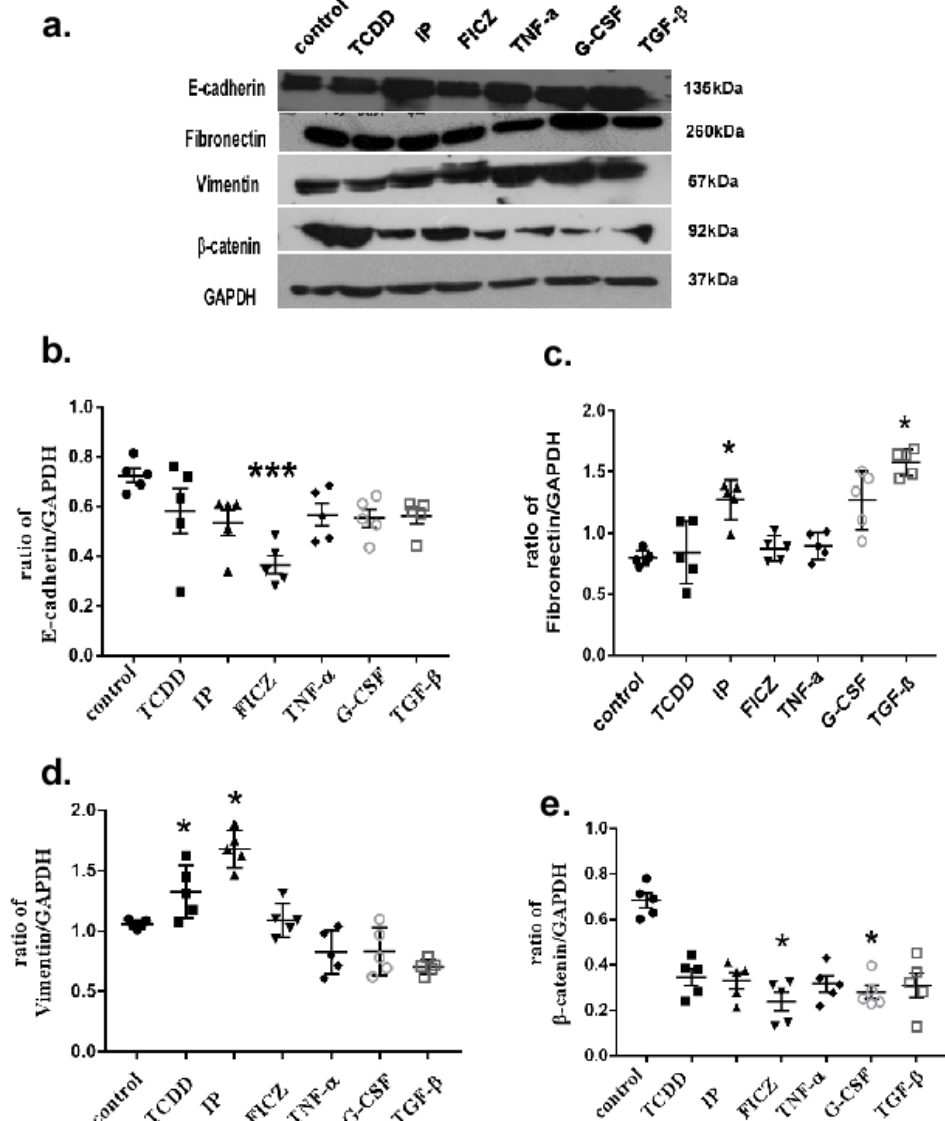
Figure 7. Activation of AhR induced epithelial EMT marker expression in MLE-12 cells. MLE-12 cells were exposed for another 24 h in serum-free DMEM/F12 media with TCDD (10 − 8 M), IP (10 − 7 M), FICZ (10 − 7 M), TNF- α (10 ng/mL), TGF- β (10 − 5 M) and G-CSF (10 ng/mL). ( a ) Representative image of western blot. ( b ) e-cadherin expression, ( c ) fibronectin expression, ( d ) vimentin expression, ( e ) β -catenin expression. Five independent experimental means ± SEM are represented in the graph. Unstimulated comparisons to control cultures were depicted by asterisks, such as * p < 0.05 and *** p < 0.001 by one-way ANOVA analysis.